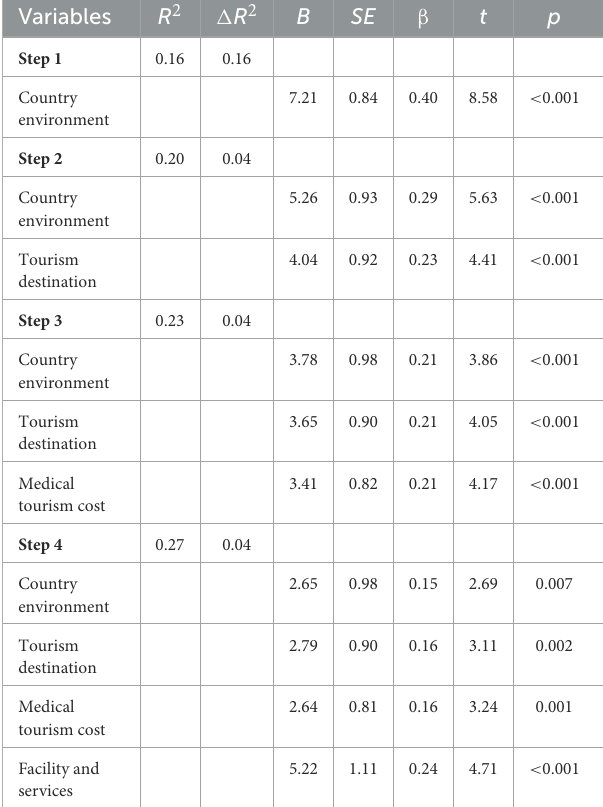
TABLE 4 Linear regression depicting factors influencing study participants’ satisfaction toward medical tourism in